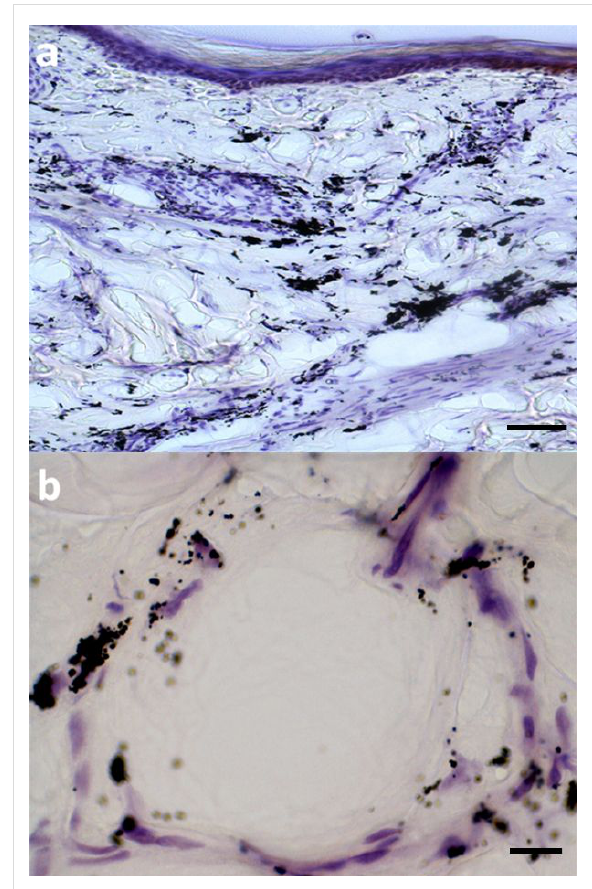
Figure 6: Light microscopy view of stained adult human tattooed arm skin. (a) Large deposits of dark ink particles distributed in a clumped manner in the dermis; scale bar 75 μ m. (b) A deep dermal vessel with aggregations of ink particles in/around vessel wall and inside some associated cells; scale bar 15 μ